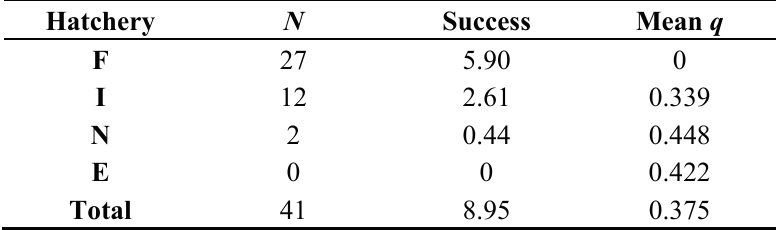
Table 5. Contribution of hatchery stocks to the High Narcea wild population, estimated by individual assignment tests to putative origin stocks. N , number of individuals of each hatchery origin identified from microsatellite data in the High Narcea. Success, percentage over the total number of samples analyzed (462). Mean q , weighted average of q (frequency of the allele LDH-C1*90) across years for each hatchery and for the whole hatchery samples